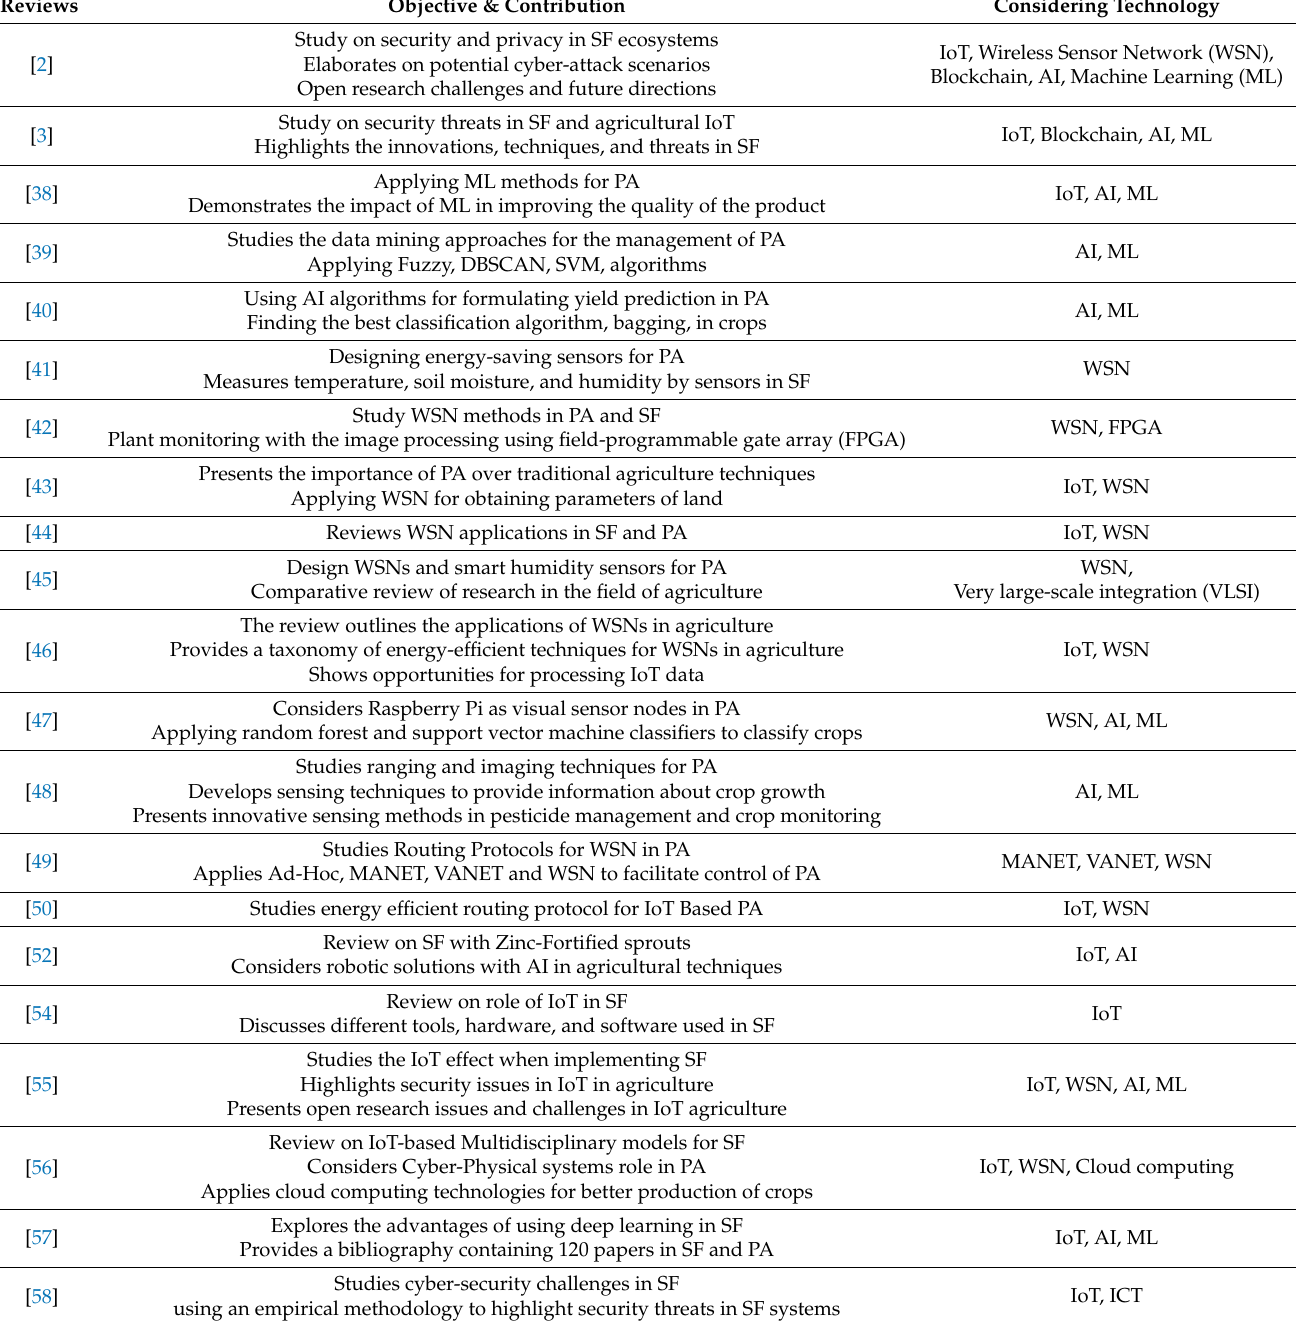
Table 1. Characteristics of the existing reviews in SF and